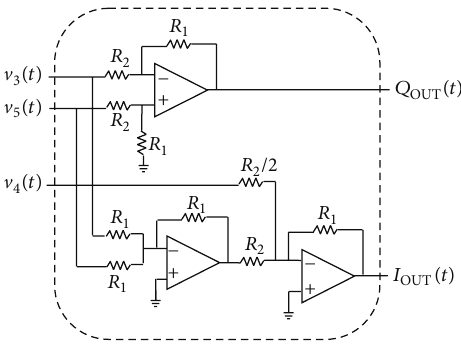
Figure 2: Architecture of the baseband analog 𝐼/𝑄 regeneration